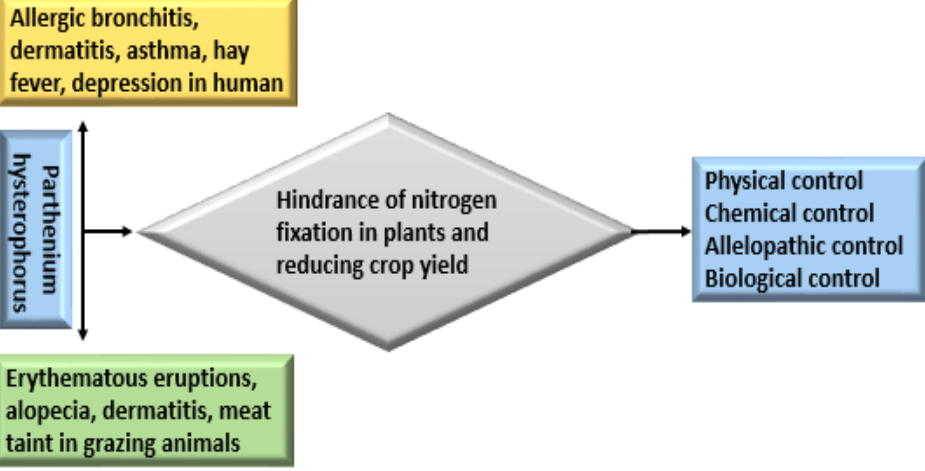
Figure 4. General detrimental effects of Parthenium hysterophorus and its control management [27].